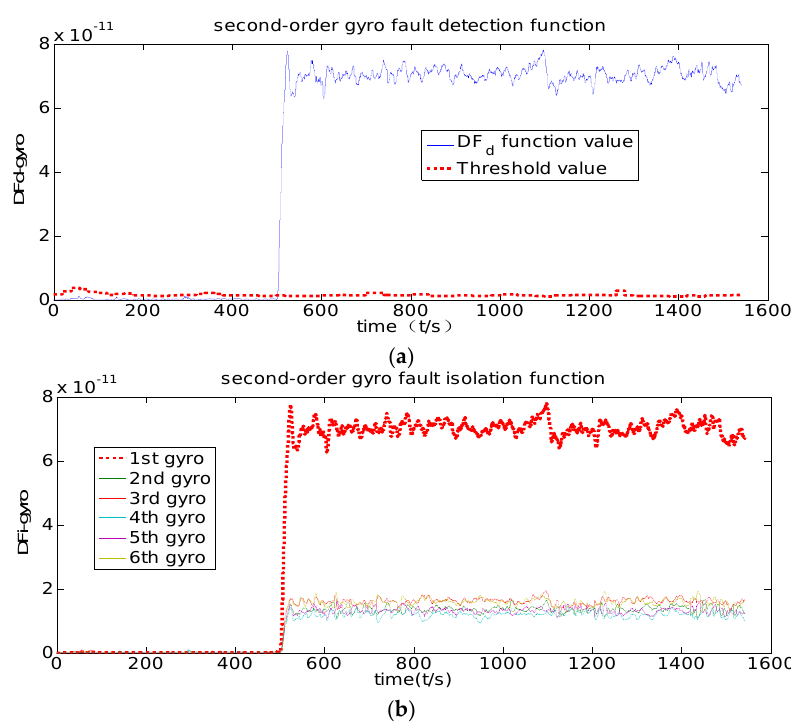
Figure 16. Second ‐ order channel filter. ( a ) Fault detection; ( b ) Fault isolation. Figure 16. Second-order channel filter. ( a ) Fault detection; ( b ) Fault isolation. Table 7. The relationship between time constant and the effect on detecting faults (square wave fault).